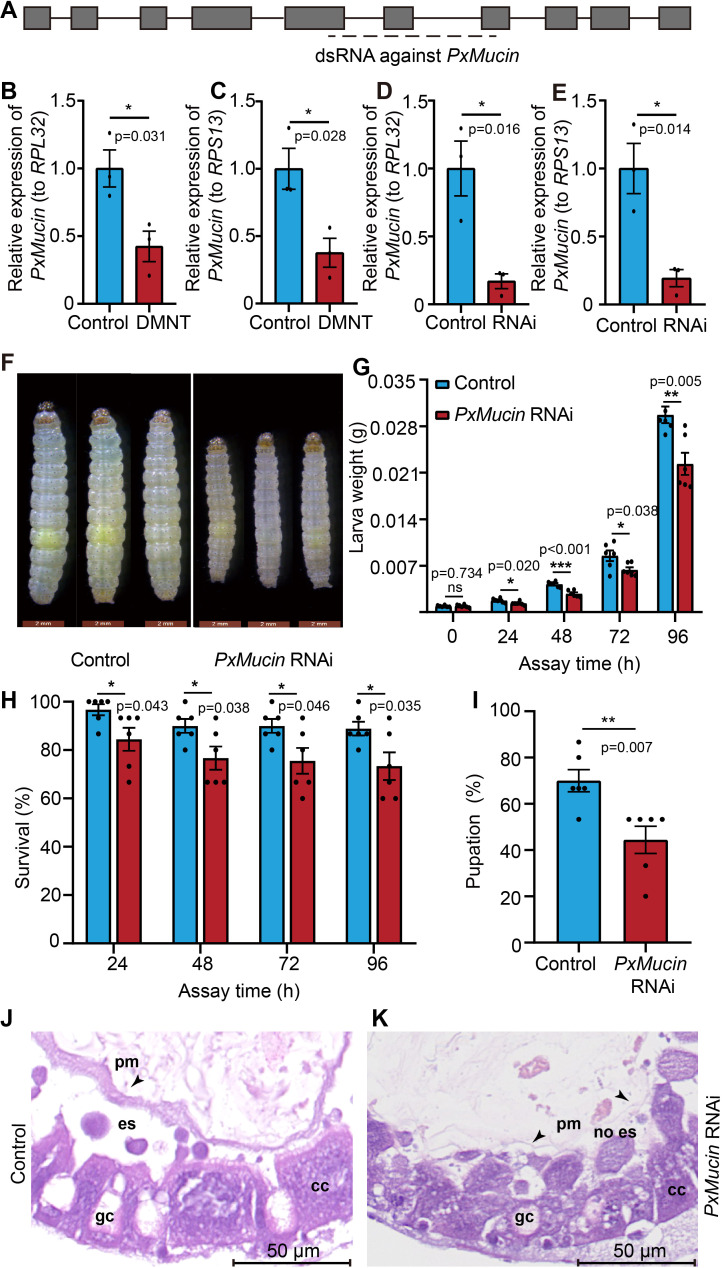
(3E)-4,8-Dimethyl-1,3,7-nonatriene (DMNT) disrupts the peritrophic matrix (PM) structure of P. xylostella larvae via repression of the mucin-like gene PxMucin.(A) Gene structure of PxMucin. Boxes represent exons, and horizontal lines represent introns. The horizontal dashed line indicates the targeted regions by double-stranded RNA (dsRNA). (B, C) DMNT treatment downregulates the expression of PxMucin. (D, E) Successful RNA interference (RNAi) of PxMucin by dsRNA feeding. (F–I) Larvae fed with dsRNA against PxMucin show impaired body development (F), weight (G), survival (H), and pupation (I) rates. (J, K) PM structure from control larvae (J) and larvae-fed PxMucin dsRNA (K). Note how PxMucin dsRNA feeding phenocopies DMNT treatment. Error bars in (B–E) represent the standard error of three independent biological replicates, with 30 P. xylostella larvae per replicate. Error bars in (G–I) represent the standard error of six independent biological replicates, with 15 P. xylostella larvae per replicate. Asterisks indicate significant differences (*p<0.05, **p<0.01, ***p<0.001, ns, not significant; two-tailed unpaired t-test).
Figure 4—source data 1.(3E)-4,8-Dimethyl-1,3,7-nonatriene (DMNT) disrupts the peritrophic matrix (PM) structure of P. xylostella larvae via repression of the mucin-like gene PxMucin.